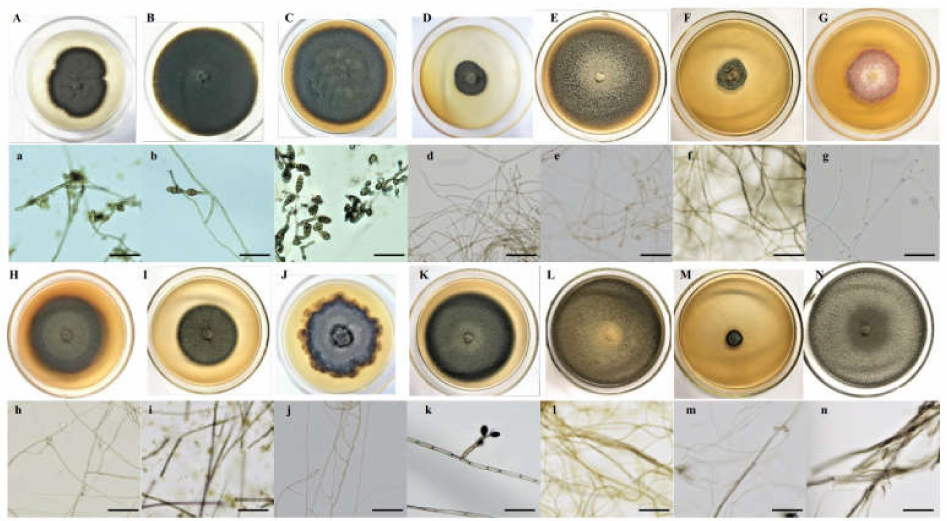
Figure 2. Colonies of dark septate endophytes isolated from the roots of Artemisia ordosica grown on potato dextrose agar (PDA) medium ( A – N ). ( a – n ), microscopic morphology of endophytic fungi (bars = 50 µ